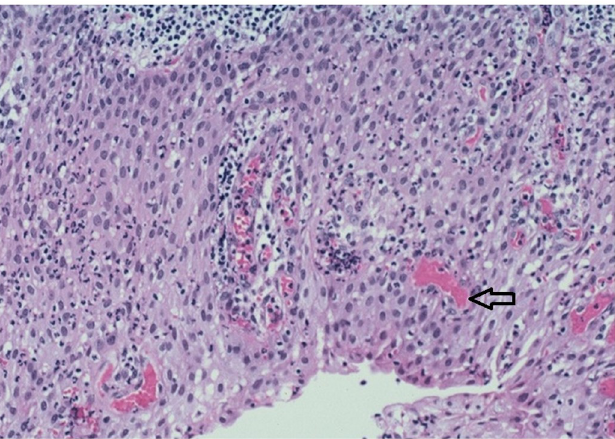
Fig 2. High power magnification of histological section (H & E staining) showing hyaline bodies in the epithelium with dense chronic inflammatory infiltrate.